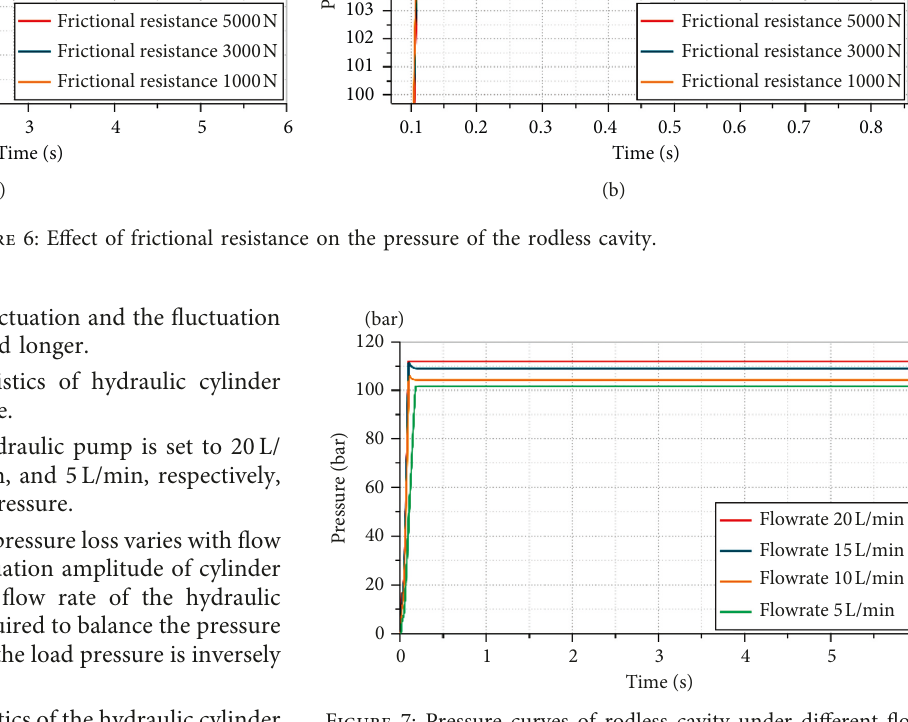
Figure 7: Pressure curves of rodless cavity under different flow rates.